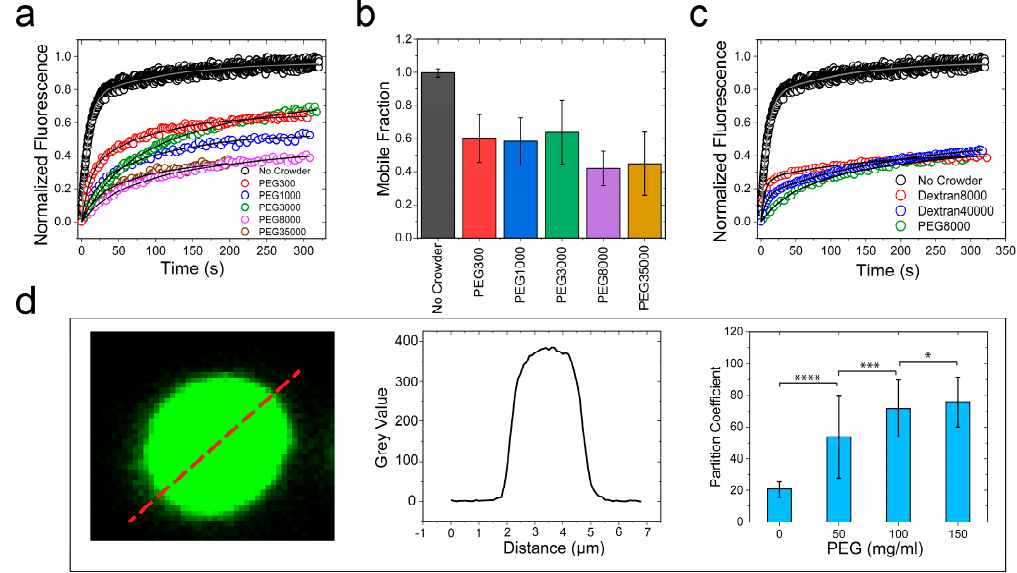
Figure 5. PEG and dextran produce similar effects on FUS FL droplet physical properties. ( a , c ) Representative FRAP traces at 150 mg/mL PEG/dextran with a wide range of molecular weights, as indicated. The corresponding FRAP images and diffusion analyses are shown in Figure S7. ( b ) The fraction of the mobile phase decreased with increasing PEG molecular weight . ( d ) Increased ribonucleoprotein (RNP) partitioning within the FUS FL droplets with increasing concentration of PEG8000, as probed by confocal image analysis. * p -value: 0.1–0.01, ** p -value: 0.01–0.001, *** p -value: 0.001–0.0001, **** p -value < 0.0001.